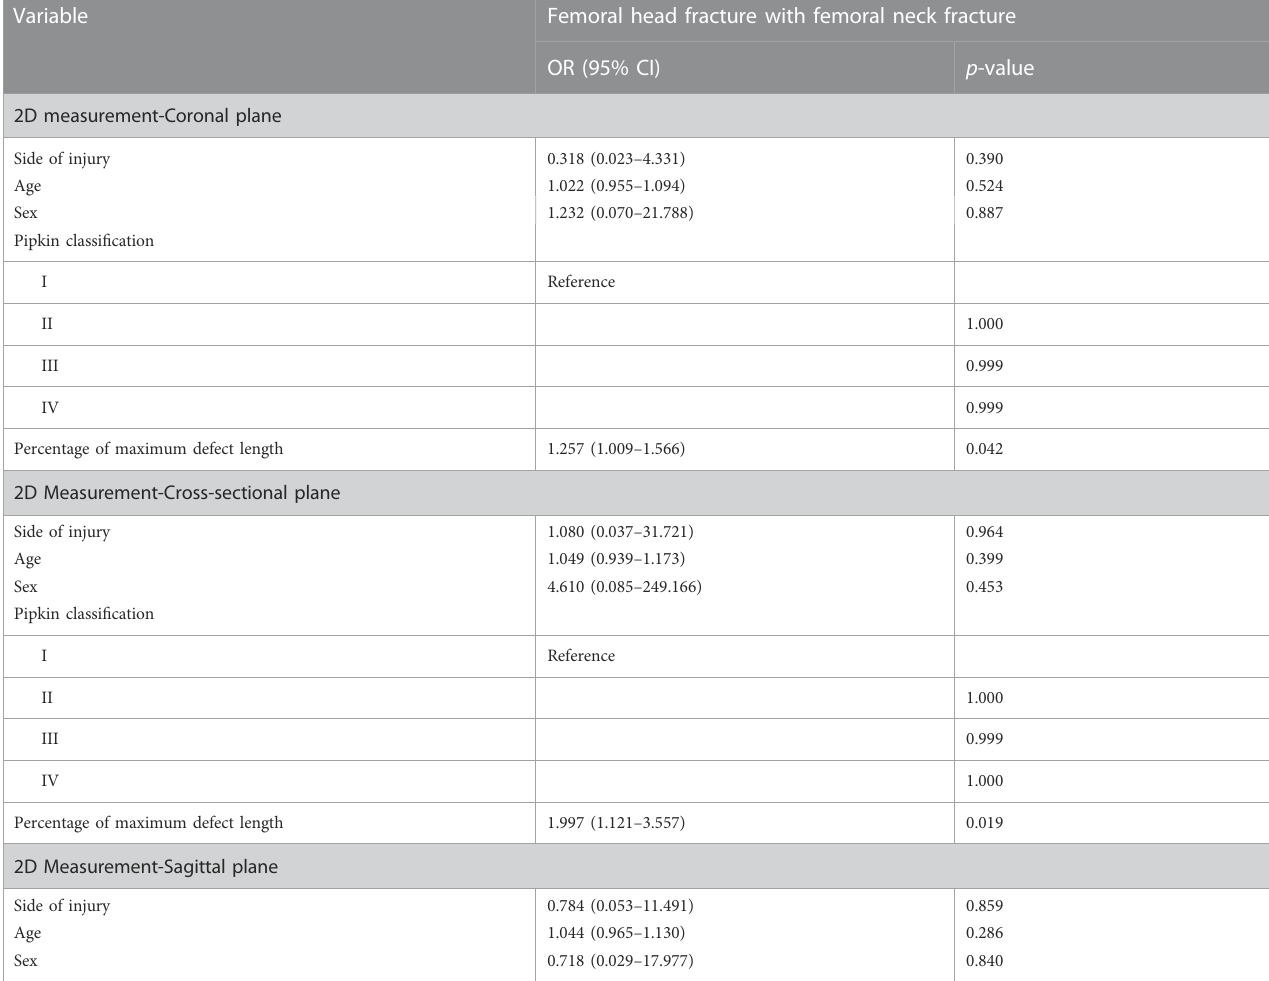
TABLE 4 Relationship between femoral neck fracture and patient characteristics for the 209 patients with femoral head fracture by multivariate binary logistic regression analysis.